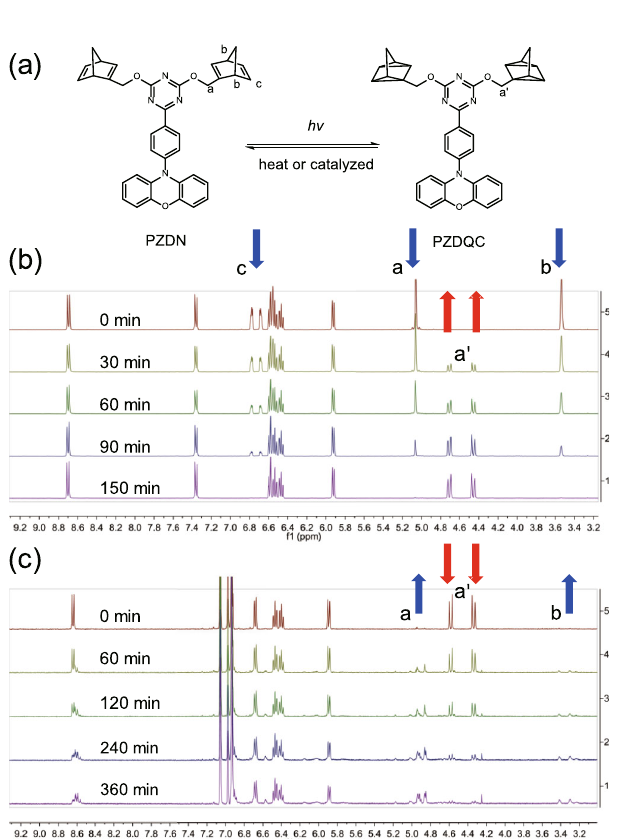
Fig. 5 PZDN → PZDQC photoisomerization and PZDQC → PZDN reverse thermal (or catalytic) isomerization. a Illustration of the reactions. b Time-